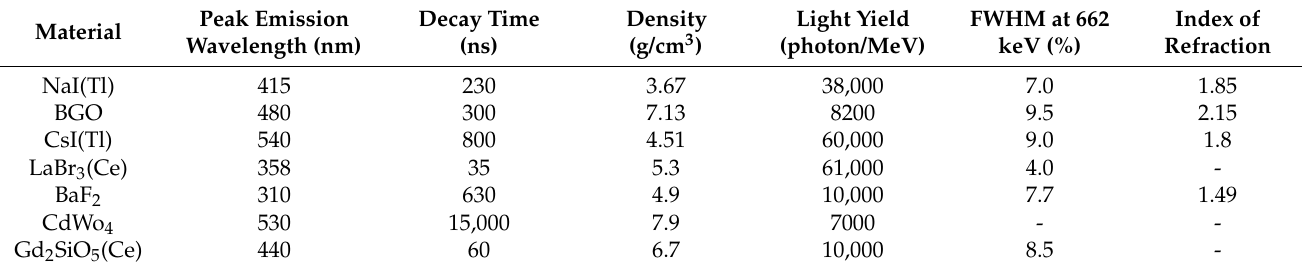
Figure 1. Schematic illustration of the various stages involved in the scintillation process modified [14 – 16]. Table 1. Types and characteristics of inorganic scintillators [14 – 25].